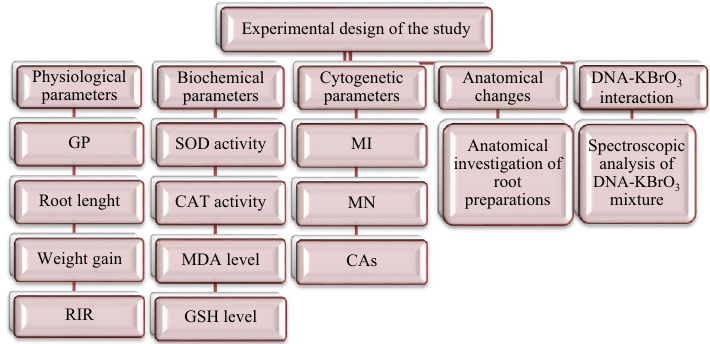
Figure 2. Experimental stages of study. GP: germination percentage, RIR: relative injury rate, SOD: superoxide dismutase, CAT: catalase, MDA: malondialdehyde, GSH: glutathione, MI: mitotic index, MN: micronucleus, CAs: chromosomal